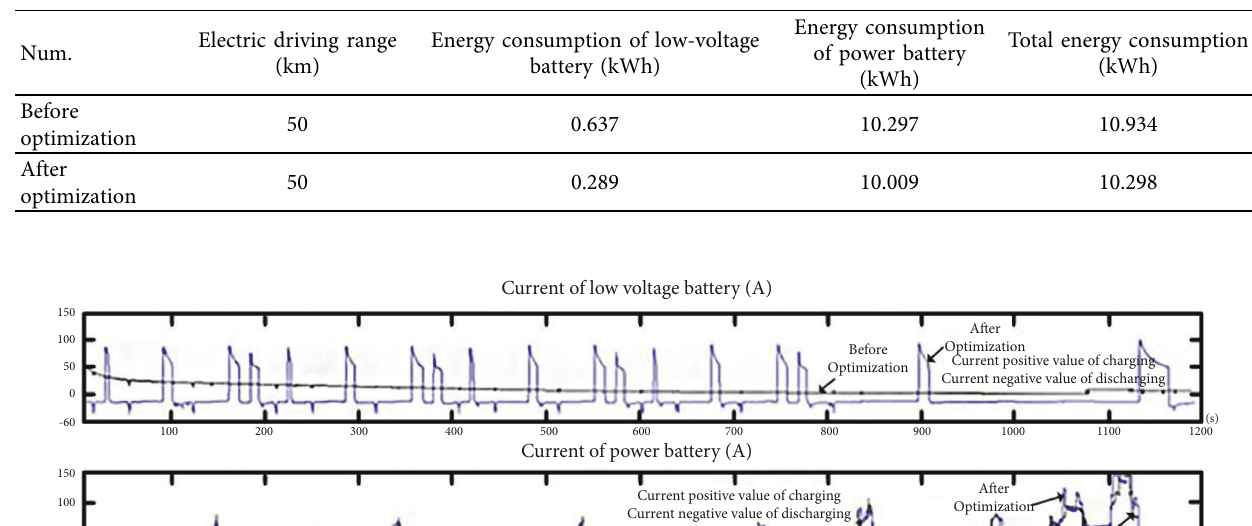
Table 3: Energy management comparison test data.